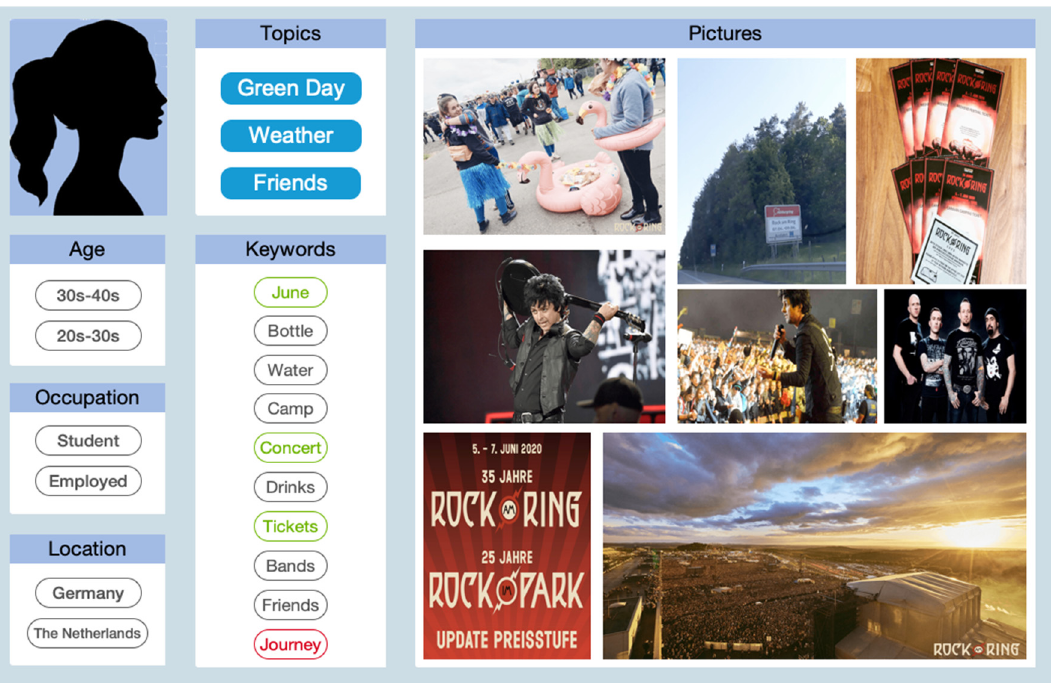
Figure 5. User ‐ constructed meta ‐ data ‐ assisted thin persona. Figure 5. User-constructed meta-data-assisted thin persona.